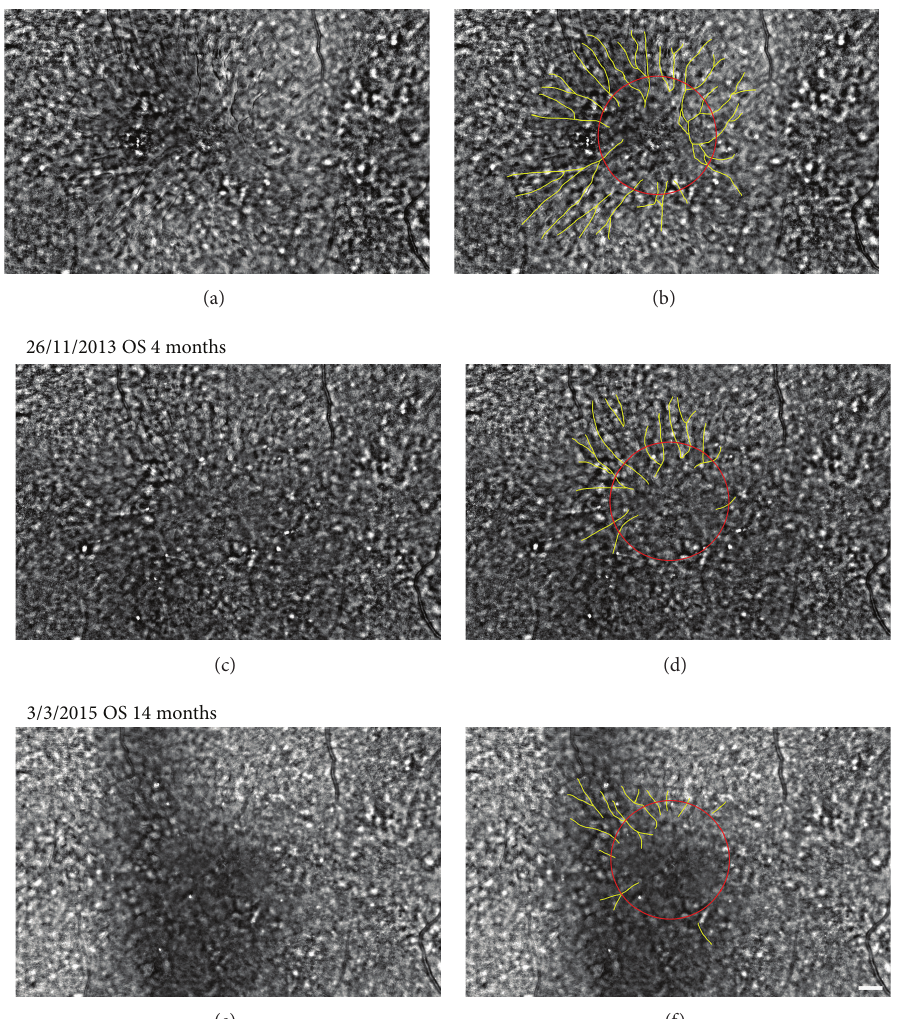
Figure 6: Time course of AO images and images (a, c, e) with highlighted retinal folds (b, d, f). (a) and (b) Baseline AO image (a) and image with highlighted retinal folds (b) of the left eye are shown. Spoke wheel pattern of retinal folds is highlighted by yellow line in (b). Red circle indicates 500 𝜇 m circle from the fixation point. (c) and (d) AO image of the same eye after 4 months of treatment with dorzolamide is shown. (e) and (f) AO image of the same eye after 20 months of treatment with dorzolamide is shown. Bar 200 𝜇